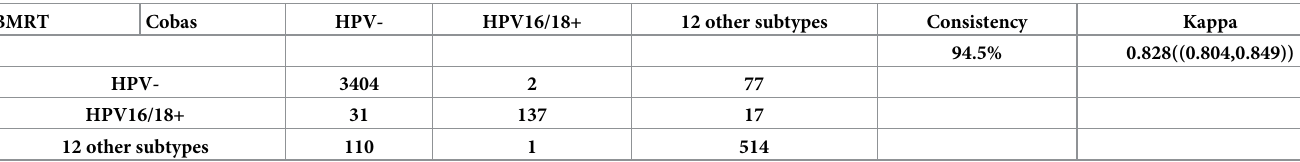
Table 3. The consistency of HR-HPV subtypes between BMRT and Cobas.